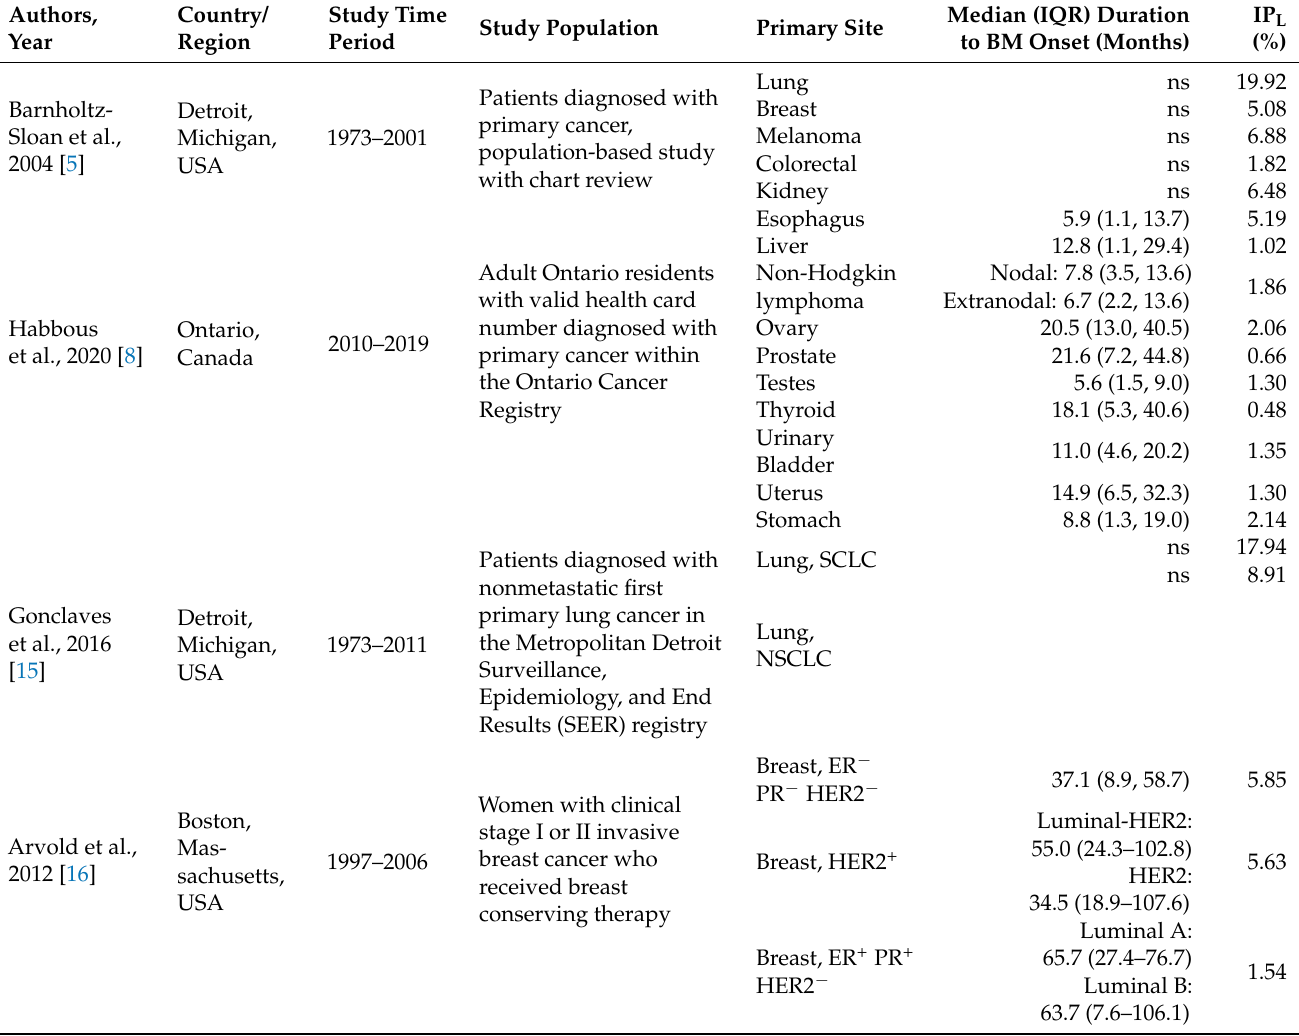
Table A2. Lifetime incidence proportion (IP L ) of BM from selected studies by site of cancer.